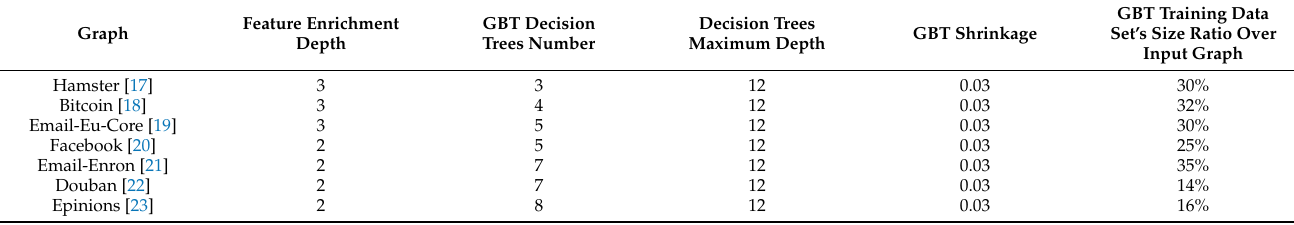
Table 5. The boosting ensemble learner’s execution parameters per distinct social graph of the distributed stacking ensemble community prediction methodology.